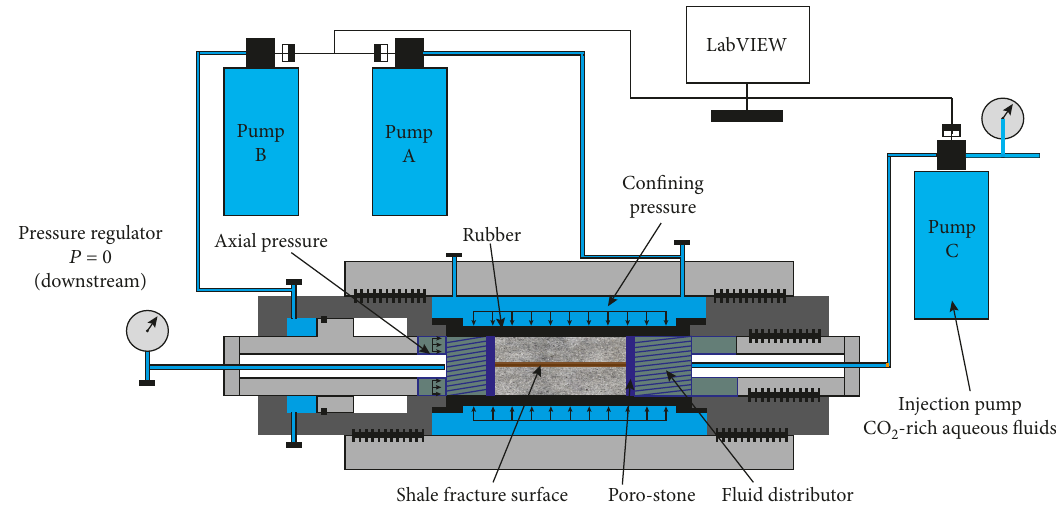
Figure 2: Experimental con fi guration for core fl ooding experiments: pump A controls the con fi ning pressure (normal stress) applied on the fracture. Pump B controls axial pressure which is set to 500kPa to ensure that the piston contacts with tightly with the sample. Pump C injects fl uid with a di ff erent acidity at a constant pressure of 120 kPa. The prepared sample is placed between two stainless steel end platens faced with fl ow distributors and sealed within a latex membrane.